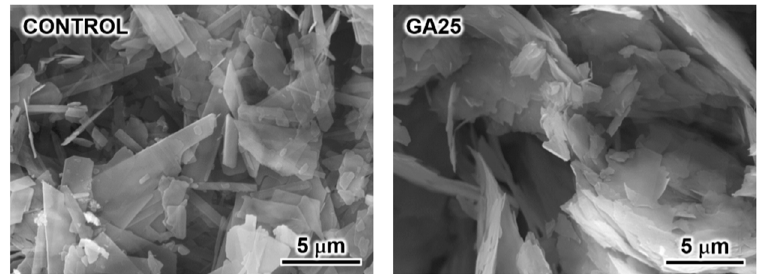
Figure 5. SEM images of plain OCP (control) and the OCP sample synthesised using 25 mmol of glutaric acid (GA25).